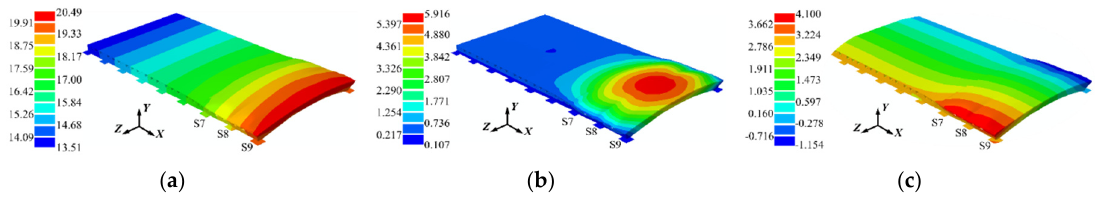
Figure 14. Deformation nephogram of the OSD (amplification factor: 400). ( a ) Ux; ( b ) Uy; ( c ) Uz.